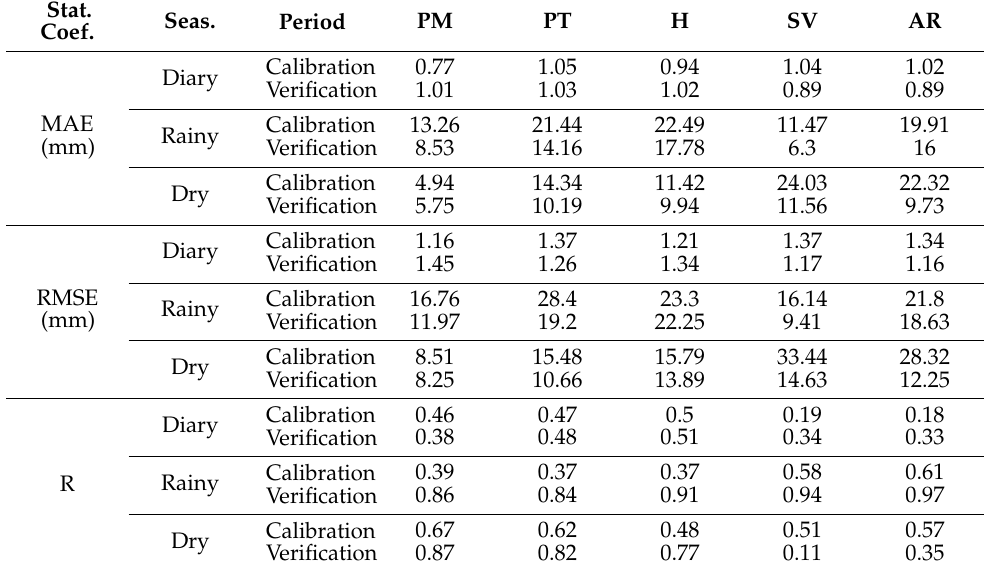
Table 4. Statistical coefficients obtained between actual evapotranspiration data obtained by EC and data simulated with the SWAT model obtained using the evaluated methodologies. Stat. Coef.